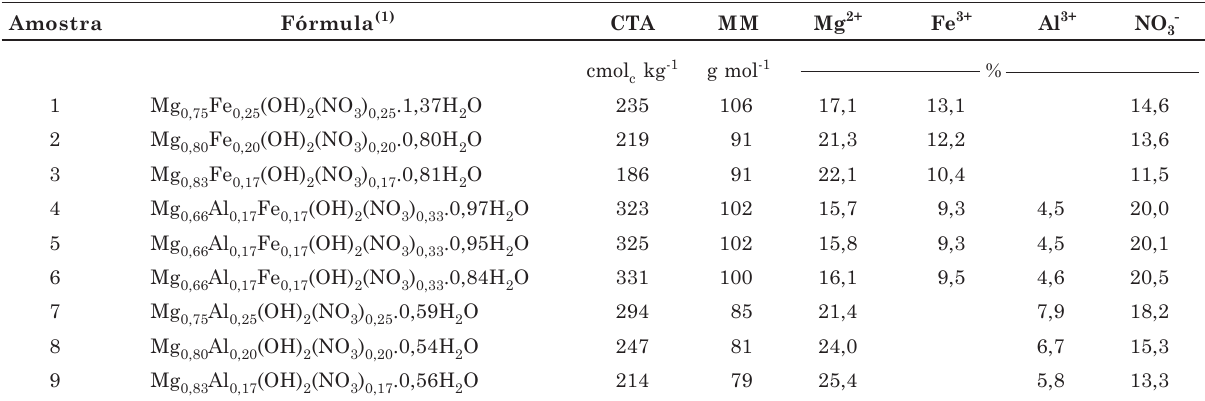
Quadro 3. Fórmulas moleculares, capacidade de troca aniônica (CTA), massa molar (MM) e teores de íons presente nos hidróxidos duplos lamelares